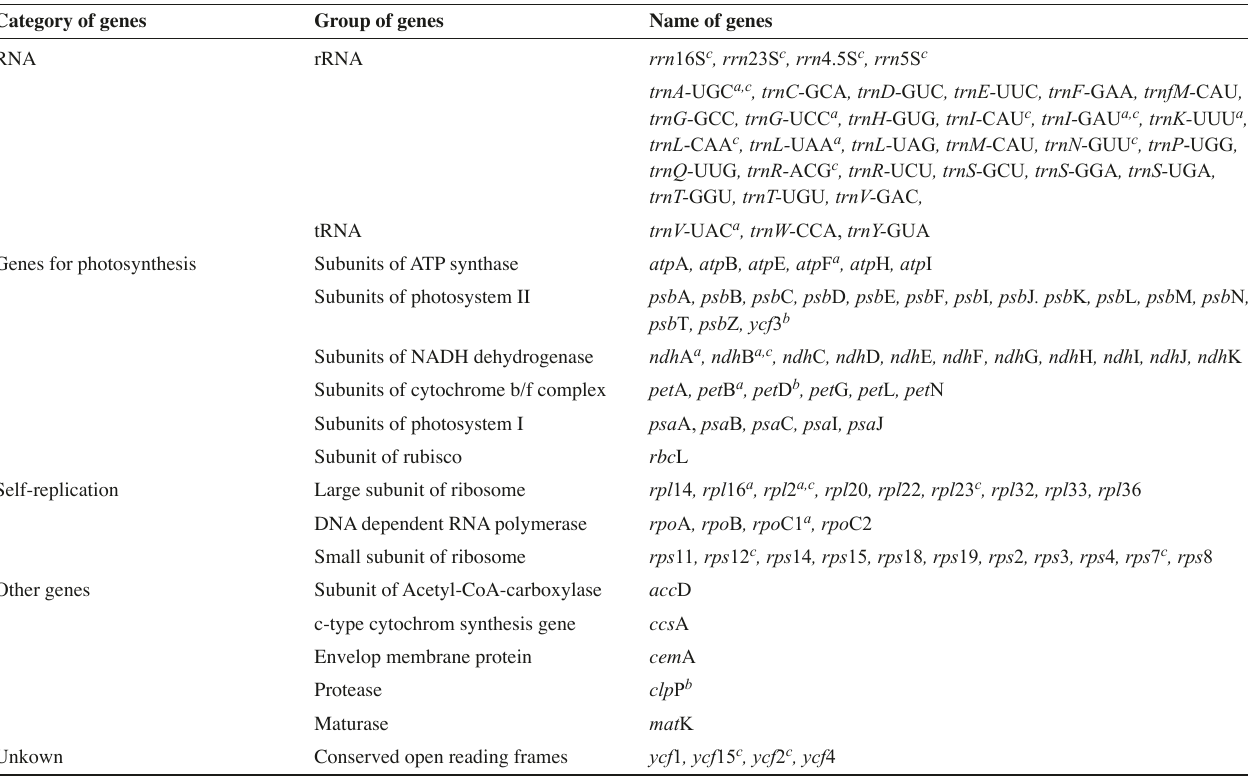
Tab. 2: Gene composition of G. triflora chloroplast genome. Category of